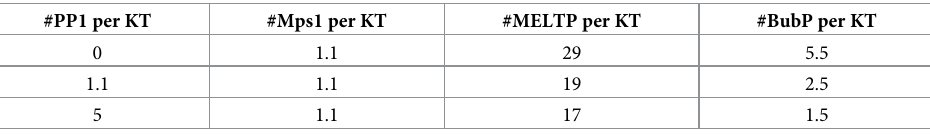
Table 3. Average number of Mps1 and SAC signaling proteins bound per KT �